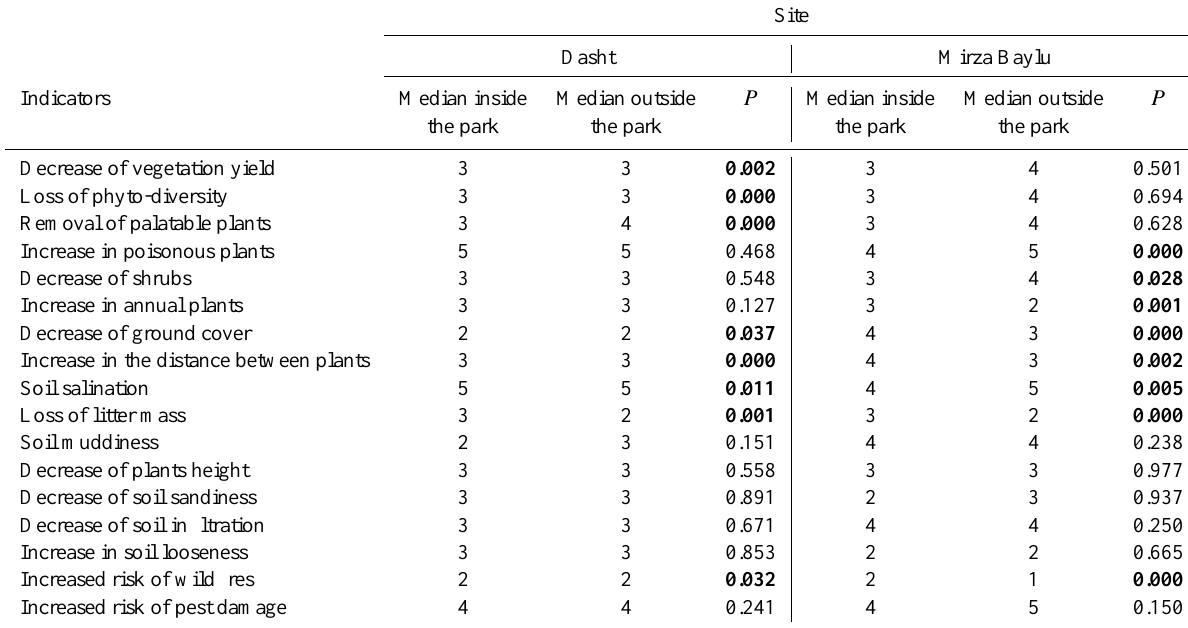
Table 3. Comparison of all identified rangeland degradation indicators between inside and outside the park for each site separately. P below 0.05 are in